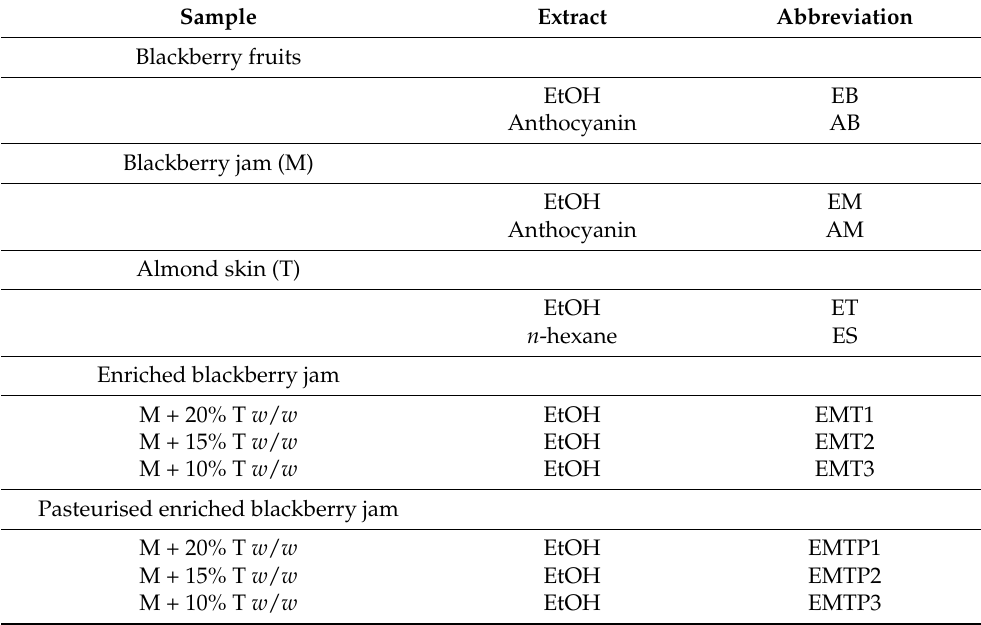
Table 1. Abbreviations used for investigated almond skin, blackberry fruits and jam, and enriched jam extracts. Sample Extract